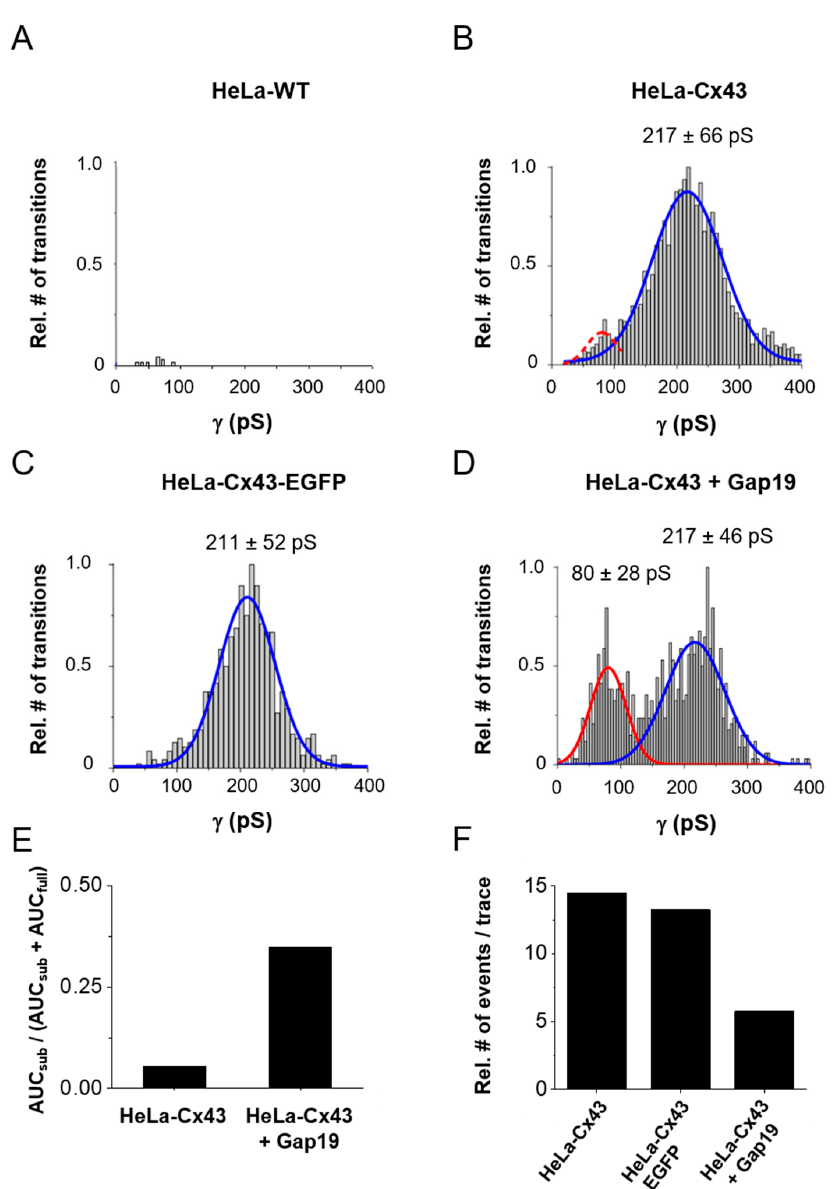
Figure 4. Distribution of transition conductance and the effect of CT-tagged EGFP and CT-interacting Gap19 peptide. ( A ) Histogram analysis of transitions expressed as conductance illustrating non-significant event activity in Hela-WT cells ( N = 3; N = 9; n = 65, 16 traces per + 40, + 50, and + 60 mV steps and 17 traces per + 70 mV step). ( B ) HeLa-Cx43 cells showed significant event activity with a unitary conductance of the transitions centered around 217 pS (66 pS SD of the distribution) ( N = 4; N = 15; n = 132, 33 traces per Vm step). ( C ) Transitions were similarly distributed in HeLa-Cx43-EGFP cells with a main peak at 211 pS ( N = 3; N = 6; n = 39, 9 traces per + 40 mV step and 10 traces per + 50, + 60, and + 70 mV steps). ( D ) The distribution was completely altered by exposure of HeLa-Cx43 cells to 100 µ M Gap19 ( N = 3; N = 8; n = 50, 12 traces per + 40 and + 50 mV steps and 13 traces per + 60 and + 70 mV steps), demonstrating a smaller main peak and the appearance of a second peak centered at 80 pS (red curve). The dashed red curve in panel ( B ) is an event frequency-adjusted scaled version of the 80 pS curve. The number of transitions were normalized to maximum observed in each cluster of the experiment. The main peaks (fully open state) were compared between the different groups by one-way ANOVA and Bonferroni post-test, resulting in no difference in conductance. ( E ) Ratios of the number of substate transitions (AUC sub ) relative to all transitions (AUC full + AUC sub ). ( F ) All transition event counts expressed per 30 s trace for the different conditions